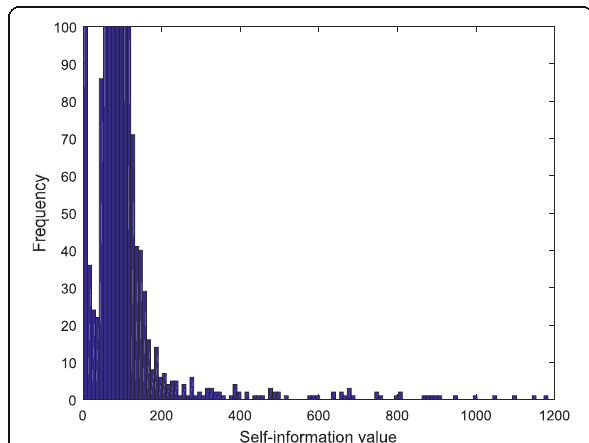
Fig. 5 The self-information statistics graph of the superpixel